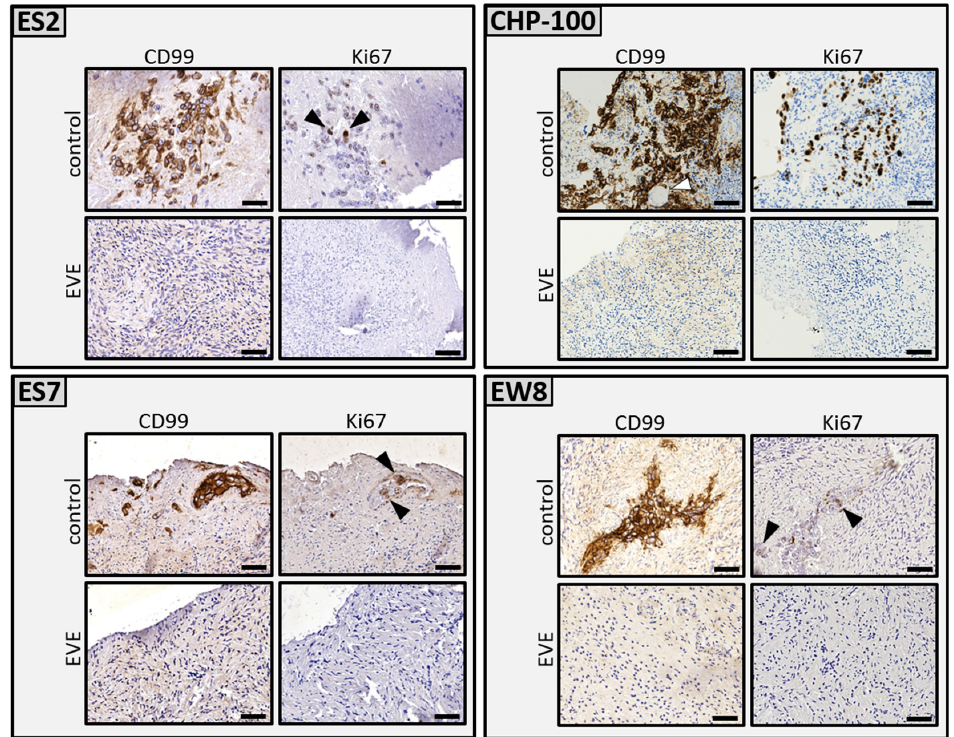
Figure 3. Ex vivo purging of ovarian cortex tissue from tumor foci of Ewing’s sarcoma. Ovarian cortex fragments from five individuals containing proliferating tumor foci of ES cell lines ES2, CHP-100, ES7 and EW8 were cut into two equal parts. One part was treated with solvent-only (control), the other part with 50 µM EVE. After purging and washing the tissue fragments were cultured for an additional 6 days to allow any remaining ES cells to form new tumor foci. Immunohistochemical staining of serial histological sections throughout the tissues revealed CD99 and Ki-67 positive tumor foci in the control tissue but not in the EVE treated tissue. Although some sections of the EVE treated tissue contained ES cell remnants, no CD99 positive tumor cells with normal morphology were detected. Arrowheads point to Ki-67 positive cells in the control tissue. Bars indicate 25 µm. EVE, Everolimus.